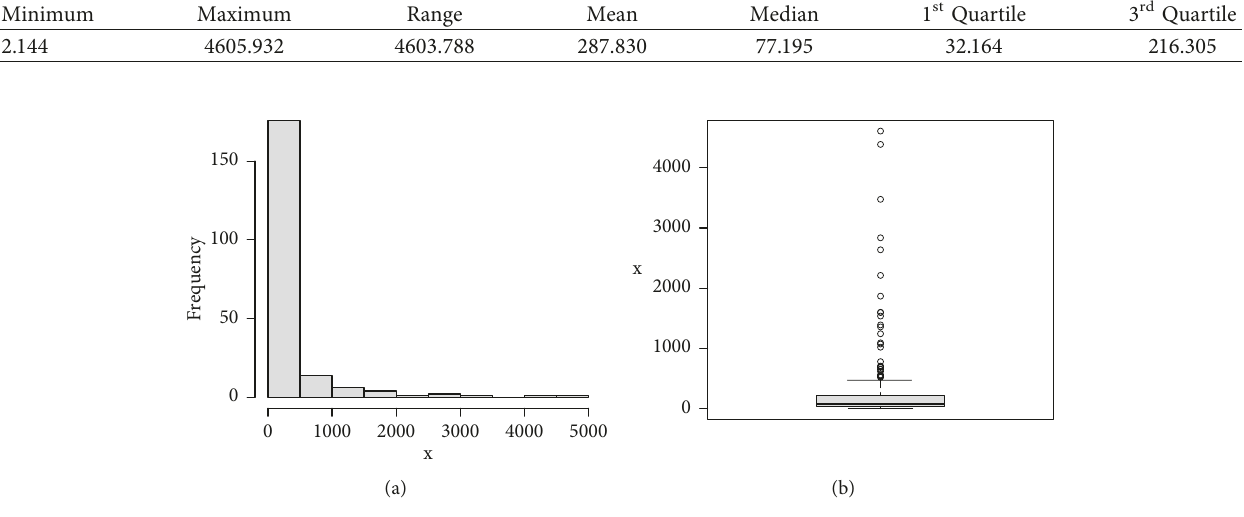
Figure 5: (a) Histogram and (b) box plot of catastrophe data. Table 6: Parameter estimates and standard errors for catastrophe data.